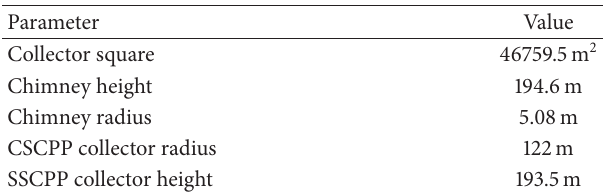
Table 1: Main parameters of the SCPPs.